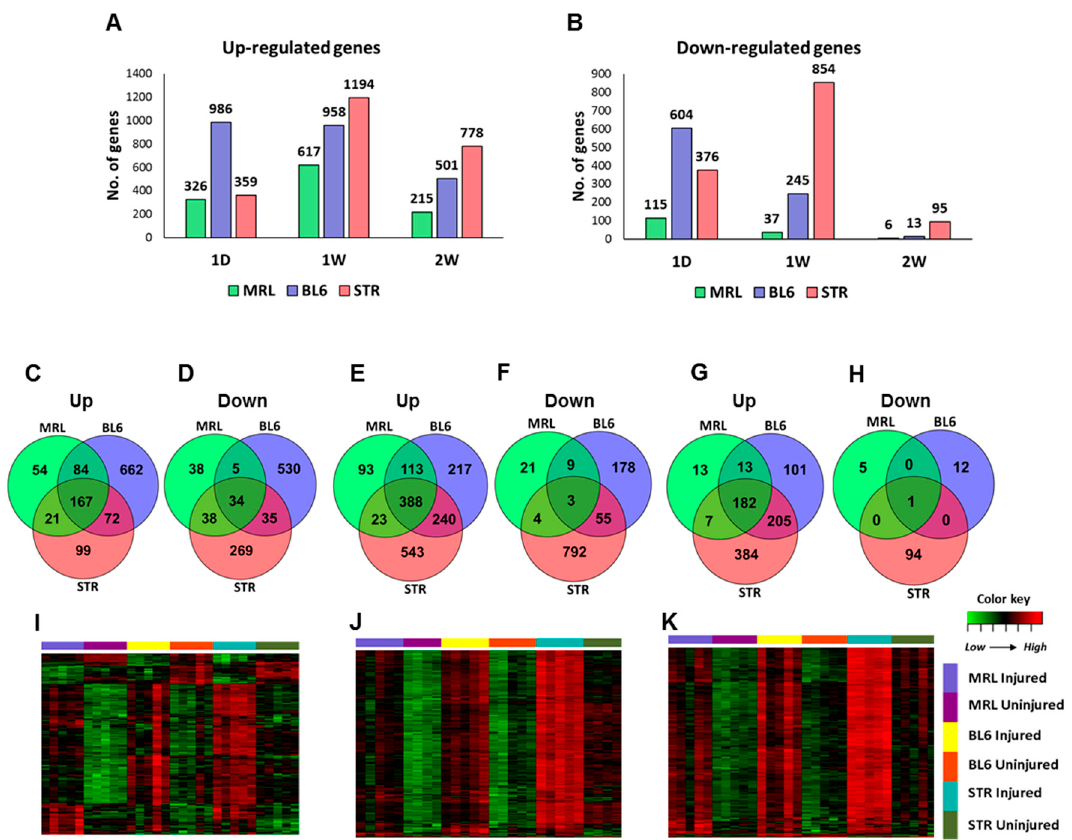
Figure 3. Early molecular changes associated with PTOA development. ( A ) Genes upregulated and ( B ) downregulated at 1-day (1D), 1-week (1W), and 2-weeks (2W) post-injury in STR/ort (STR), C57BL/6J (BL6), and MRL/MpJ (MRL). Overlap between genes ( C ) upregulated and ( D ) downregulated at 1-day post-injury. Overlap between genes ( E ) upregulated and ( F ) downregulated at 1-week post-injury. Overlap between genes ( G ) upregulated and ( H ) downregulated at 2-weeks post-injury. Genes upregulated in all three strains at ( I ) 1-day, ( J ) 1-week, and ( K ) 2-weeks post-injury. Majority of these injury-induced genes showed highest expression in injured STR. Table 1 . Cytokines upregulated in knee joints after anterior cruciate ligament (ACL) injury. Fold upregulation (log2 scale) in injured joints compared to uninjured joints are shown in the table. ns: not significantly differentially expressed.